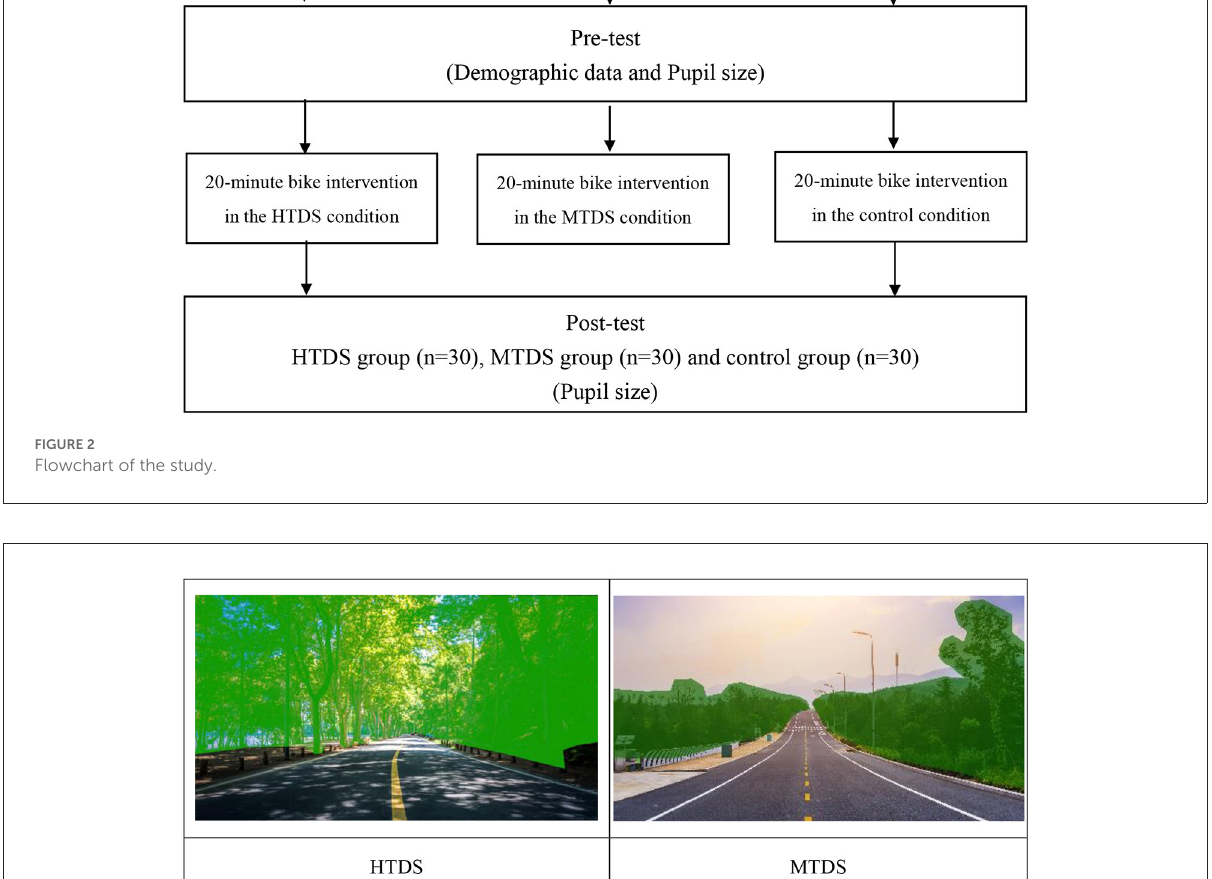
individuals felt the observed stimulus more attractive to them (26, 59). The total fixation time is the processing time when the individual to observe the stimuli, with longer total fixation